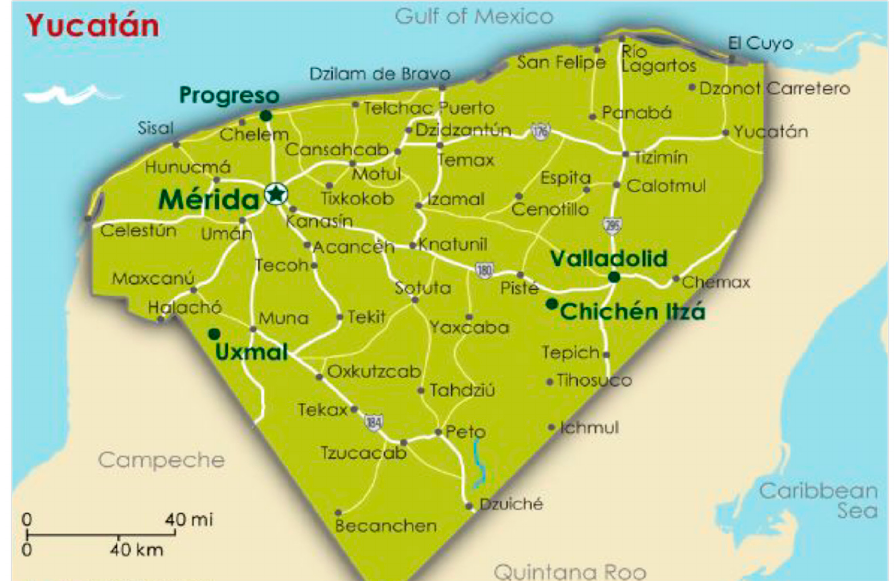
Figure 3. Geographical location of the State of Yucatan (Mexico) and main municipalities. Source: https://www.mapade.org/yucatan.html.